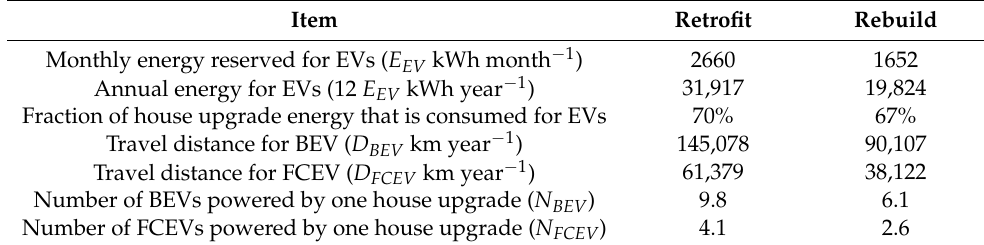
Table 7. Number of personal EVs that can be operated using the energy that is made available from retrofitting/rebuilding a single-detached